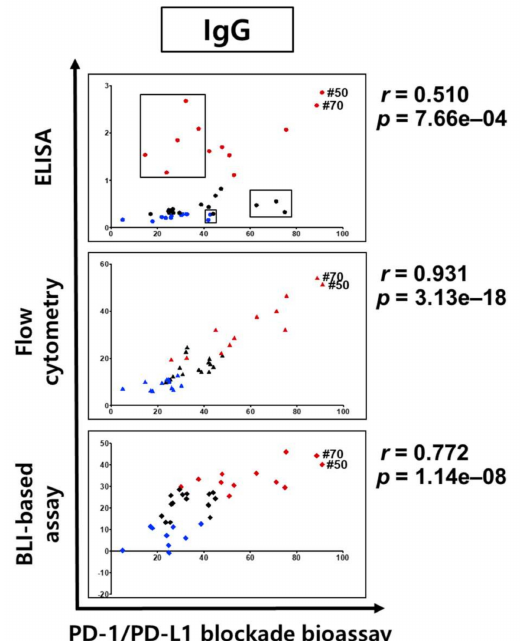
Figure 5. Correlation analysis of binding and inhibitory activities of IgG format antibodies. Comparative analysis of binding specificities and in vitro activity according to antibody formats. The vertical axis is the binding and binding inhibition activity in ELISA (circle, 450 nm), flow cytometry (triangle, MFI; mean fluorescence intensity), and BLI-based PD-1 / PD-L1 binding inhibition assay (diamond, inhibition %), and the horizontal axis is the PD-1-PD-L1 interaction inhibitory activity (relative luminescence %) of the antibodies. For the BLI-based PD-1-PD-L1 binding inhibition assay using IgG, clones #41 (-144%) and #71 (-37.63%) are not indicated. Poorly correlated clones are represented by three black boxes. The Pearson correlation coe ffi cient ( r ) and p -value ( p ) are given in the top panel ( r = 0.510, p = 7.66 × 10 − 4 ), middle panel ( r = 0.931, p = 3.13 × 10 − 18 ), and bottom panel ( r = 0.772, p = 1.14 × 10 − 8 ). Results are classified using color shading codes, with the top 30% in red and the bottom 30% in blue (IgGs; 30%; 12 / 40 clone) in each of the three assays (ELISA, flow cytometry, and BLI-based PD-1 / PD-L1-binding inhibition